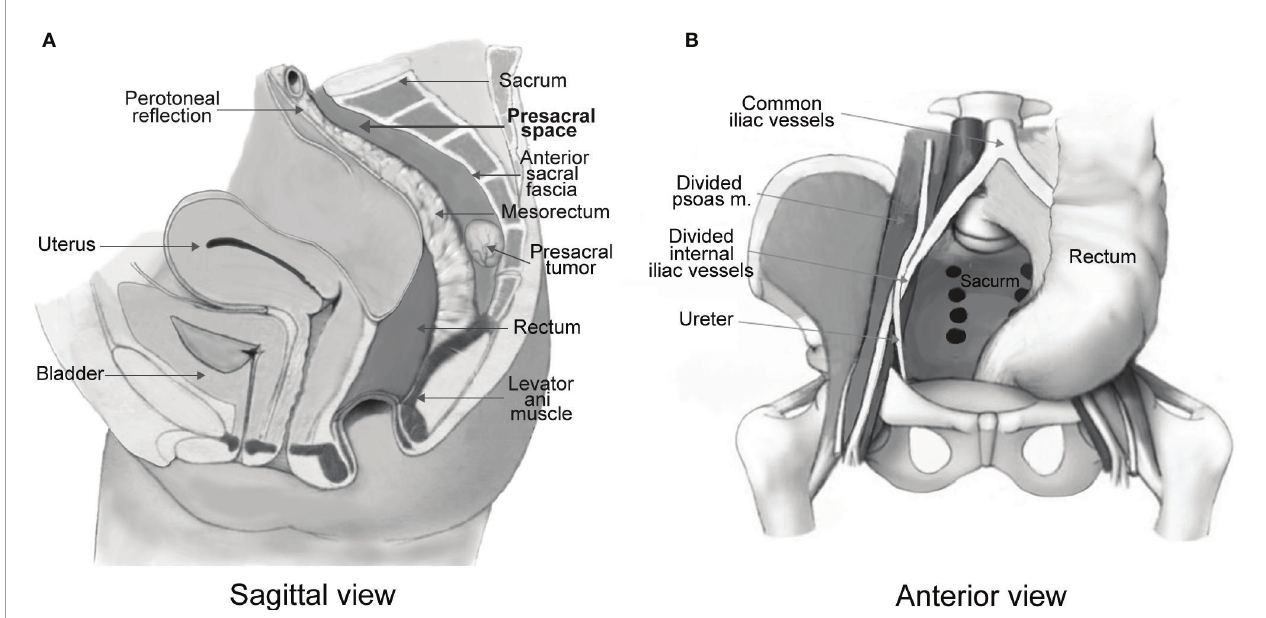
FIGURE 1 | Anatomical illustration of a presacral tumor in relation with the presacral space (A) . The presacral space is formed with the rectum and mesorectum in the anterior, the anterior sacral fascia in the posterior, the levator ani muscle in the inferior, the peritoneal re fl ection in the superior (A) , and the iliac vessels and ureters laterally (B) . Illustrations are modi fi ed from Dozois and Marcos